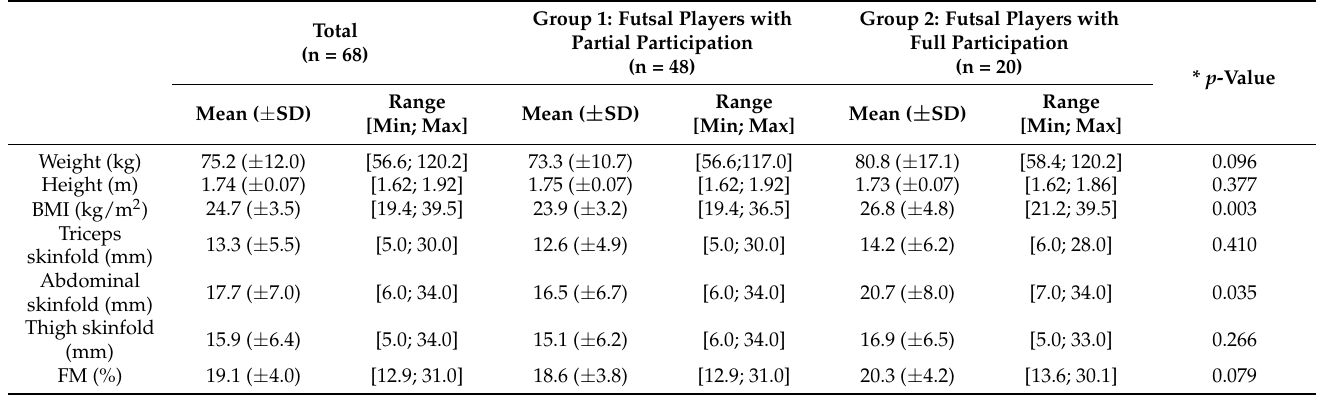
Table 2. Anthropometric and body composition characteristics of male futsal players, as a function of participants’ phases of research completion.